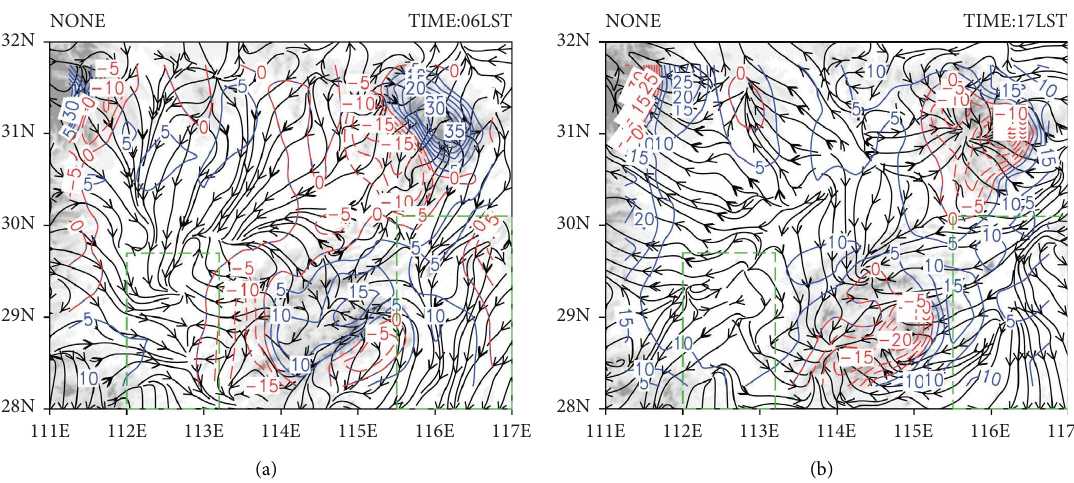
Figure 7: Te average divergence at 925hPa (the red line represents convergence, the blue line represents divergence, and the unit is 10 − 6 s − 1 ) and surface fow (stream) at 06:00 (a) and 17:00 (b) on non-HHR